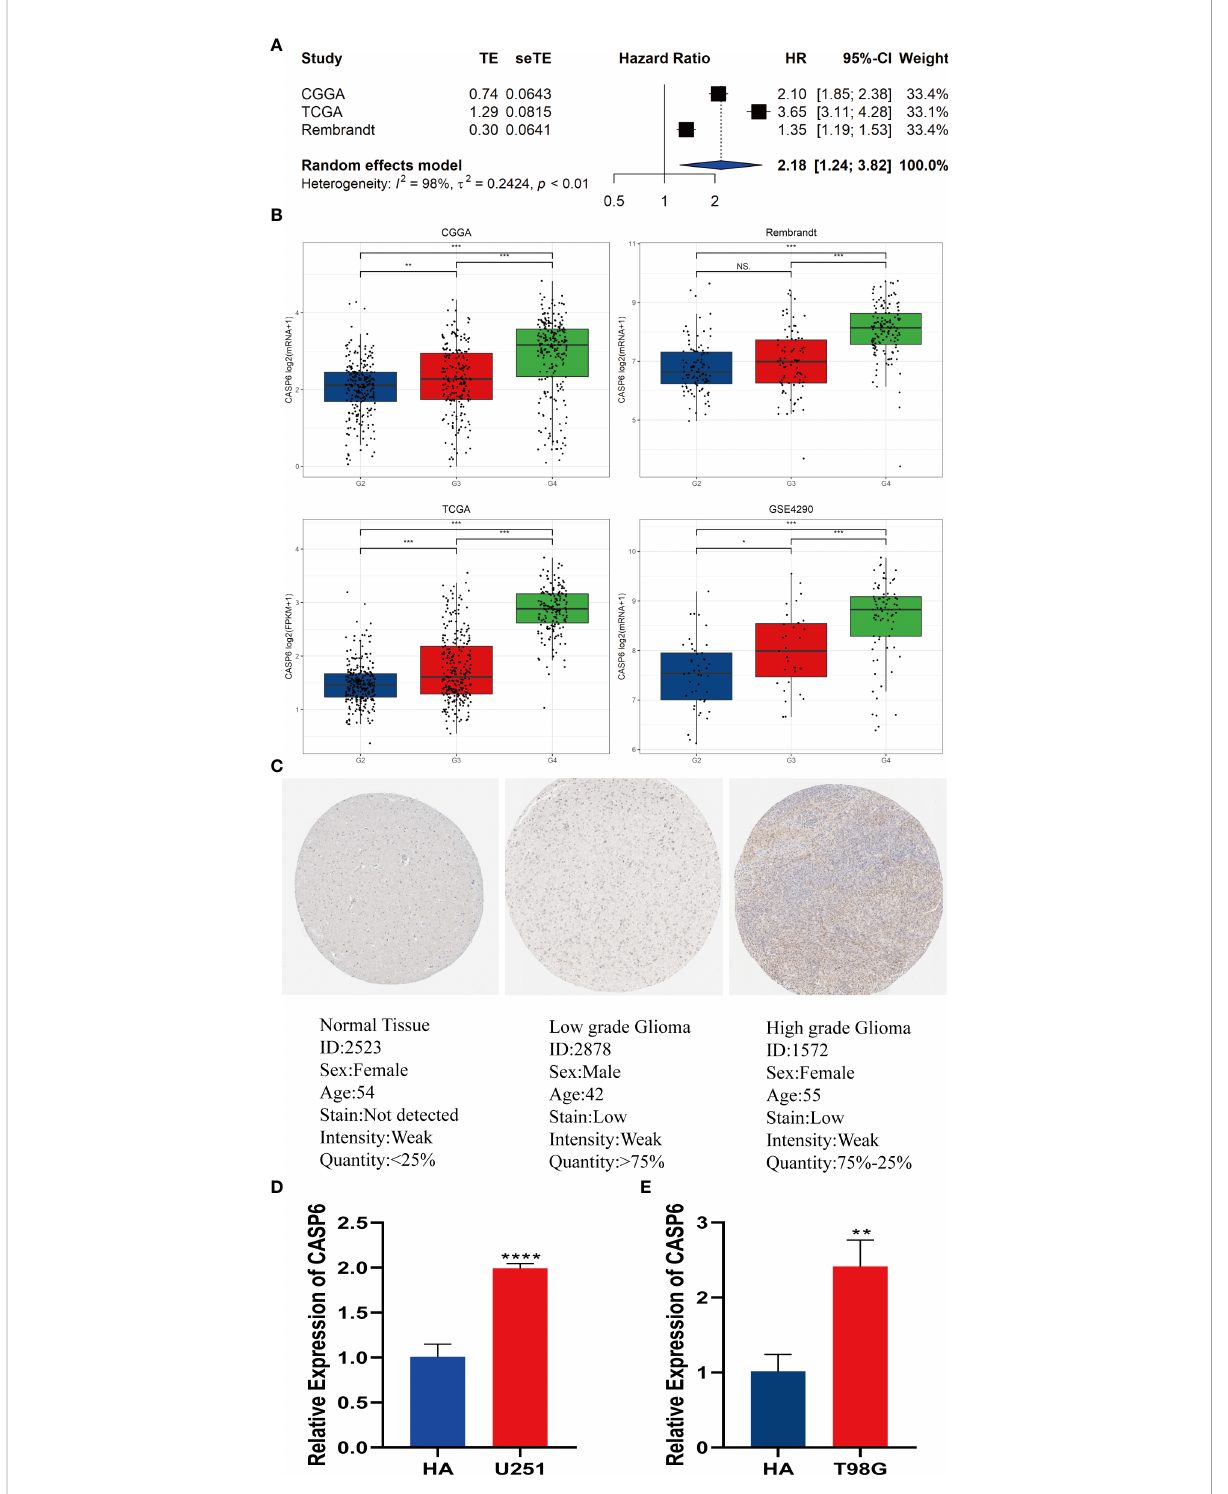
FIGURE 7 Meta-analysis of CASP6 and its expression level in gliomas. (A) Meta-analysis of CASP6 in the CGGA, TCGA and REMBRANDT databases. (B) CASP6 expression increased with disease progression of glioma (G2: Grade2, G3: Grade3, G4:Grade4). (C) Differentially expression of CASP6 in glioma and normal tissues in The Human Protein Atlas database. (D) qRT-PCR indicated that the expression of CASP6 was upregulated in U251 cells compared with that in HAs. (E) qRT-PCR indicated that the expression of CASP6 was upregulated in T98G cells compared with that in HA. * P < 0.05, ** P < 0.01, *** P < 0.001, **** P < 0.0001. NS: no signi fi